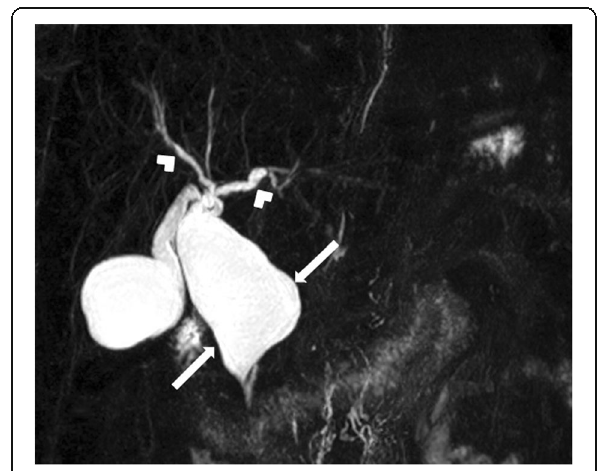
Fig. 7 A 48-year-old female patient presenting with jaundice. Coronal plane MRCP MIP image shows fusiform dilation of the common bile duct (arrows). Also, note is made of mild dilation in